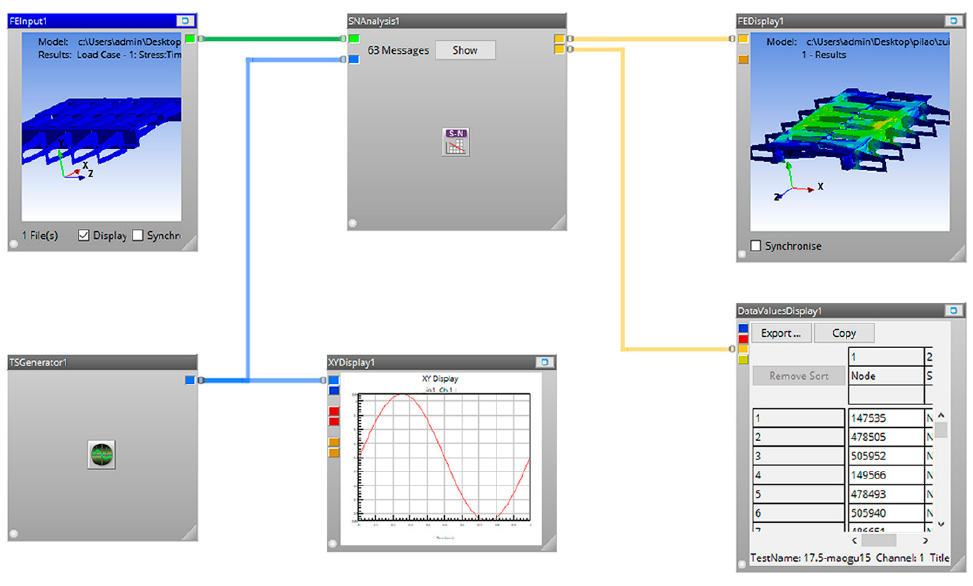
Figure 18. The interface of fatigue analysis.